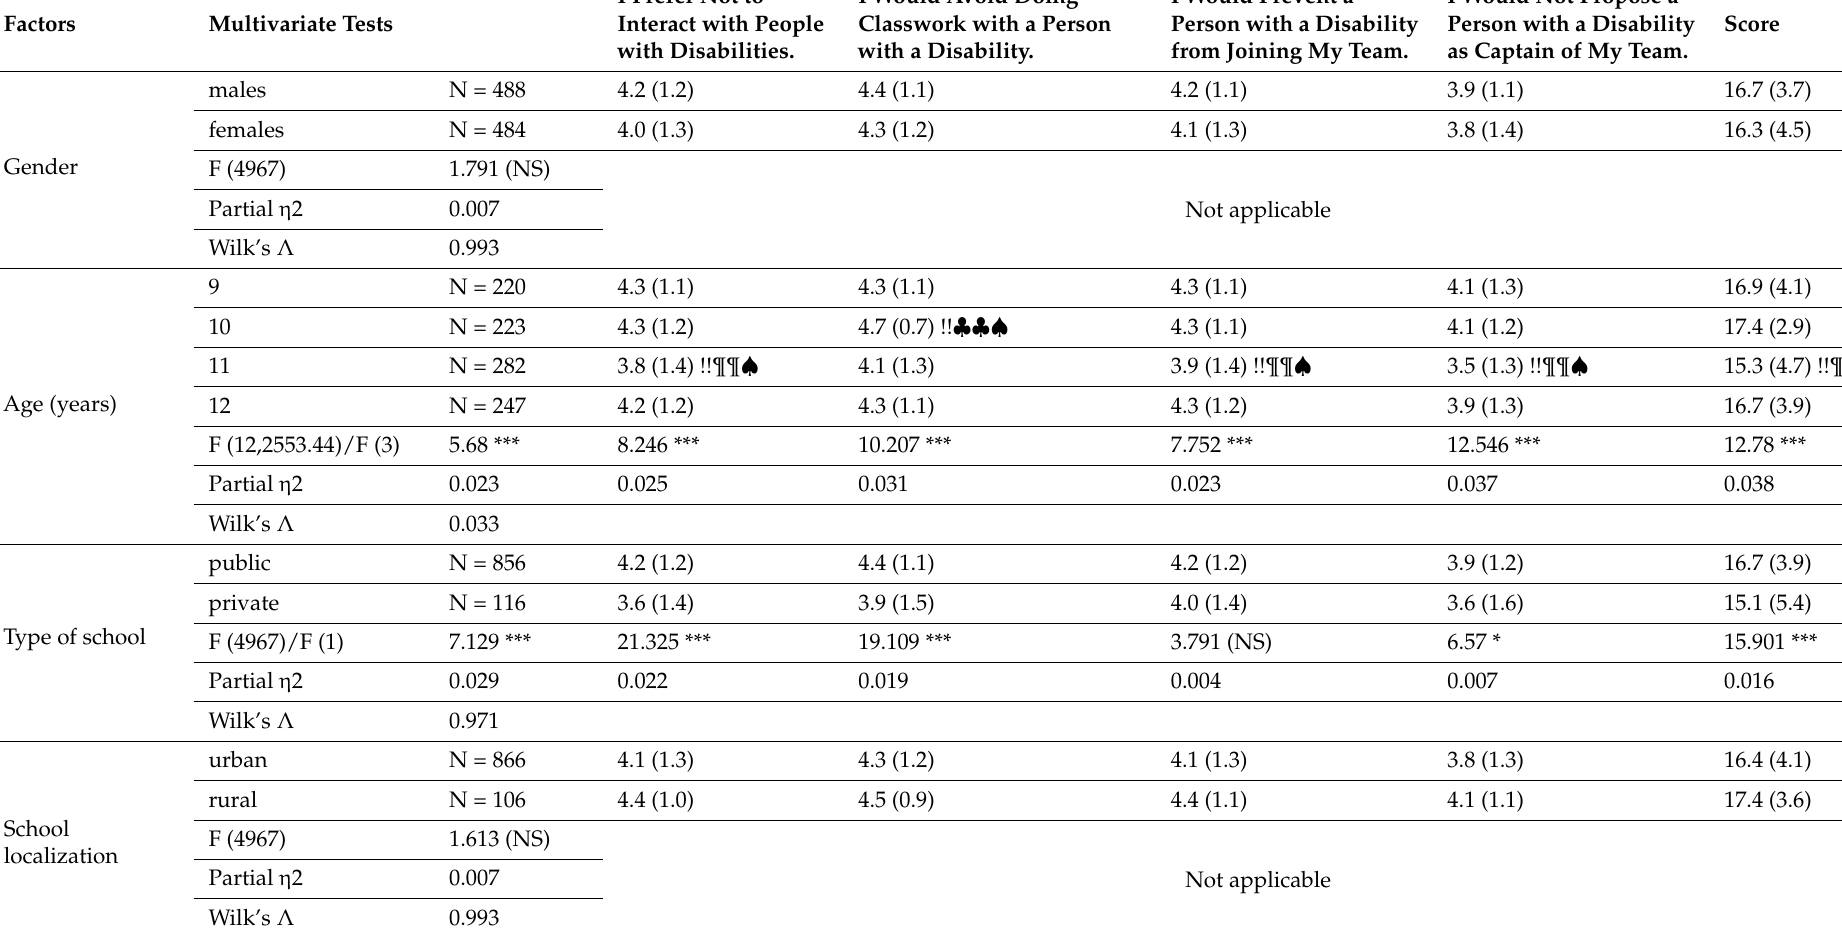
Table 1. Specific items score and the overall score of the participants’ attitudes toward disability in physical education lessons among Saudi students aged 9–12. Tests of between-Subjects